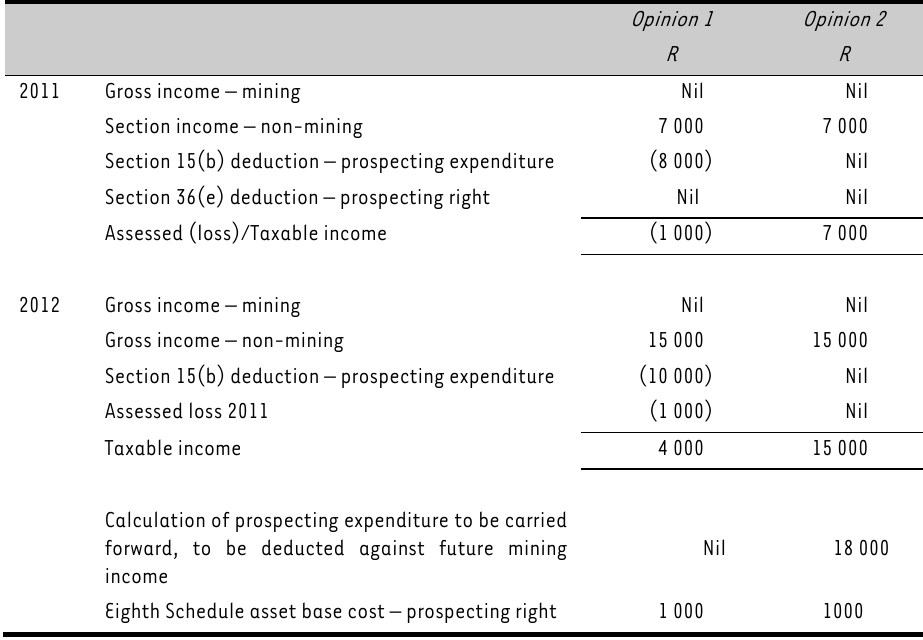
Intention to establish a mine: tax implications of prospecting expenditure